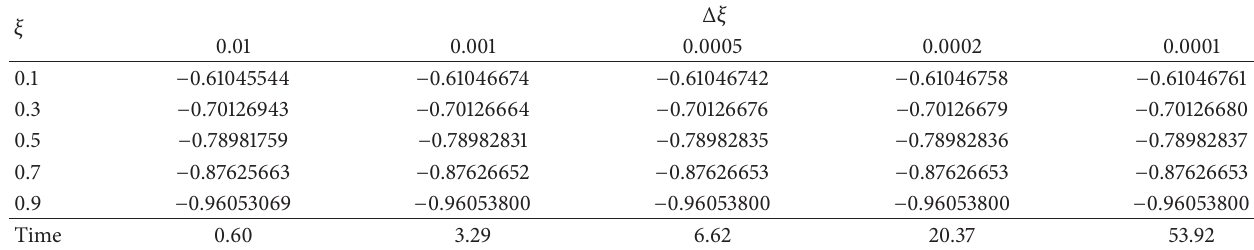
Table 2: Skin friction 𝑓 󸀠󸀠 (0, 𝜉 ) for various values of 𝜉 computed using SQLM.